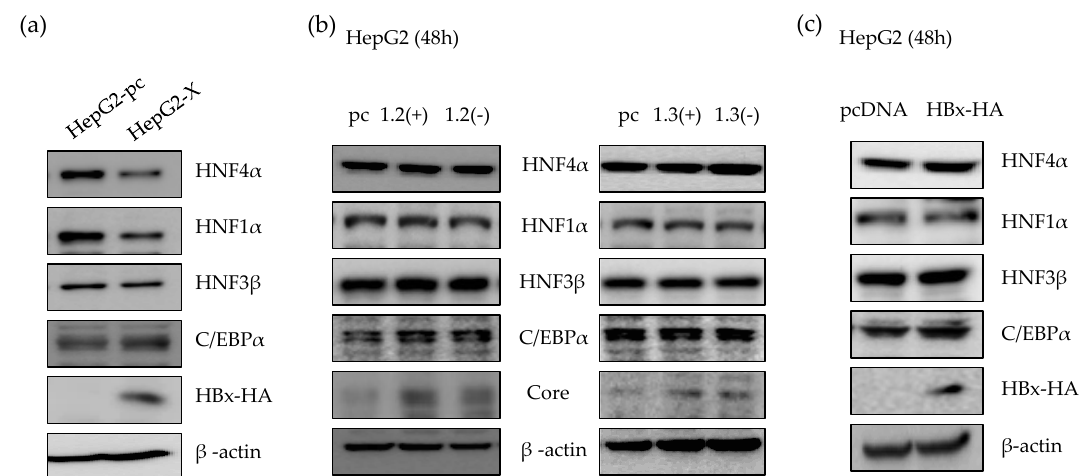
Figure 2. Suppression of HNF4 α via HBx protein in long-term expression of HBV. ( a ) The level of proteins in HepG2-pc, HepG2-X cell lines were analyzed by Western blot. ( b , c ) HepG2 cells were transfected with 2 µ g of indicated plasmids per well in a 6-well plate and harvested after 48 h. The levels of proteins were determined by Western blotting. The data represent the results from three independent